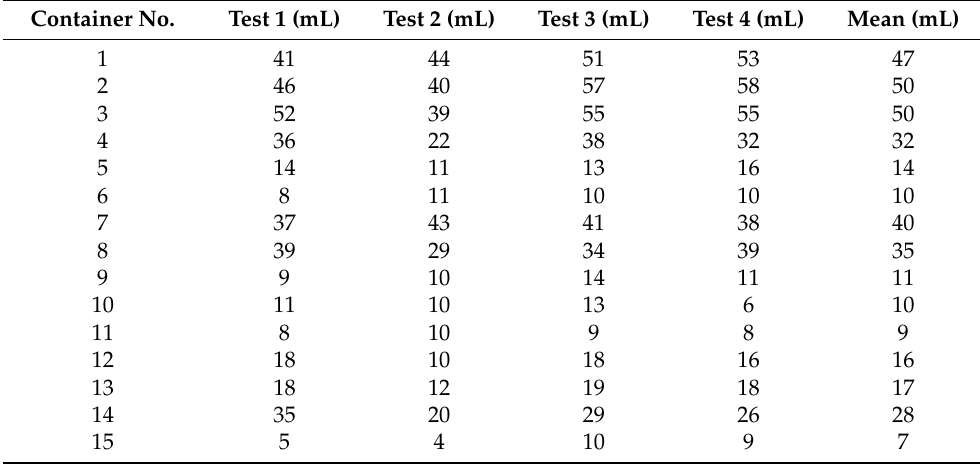
Table 1. Calibration results for the simulator hanging from the wooden structure. Container